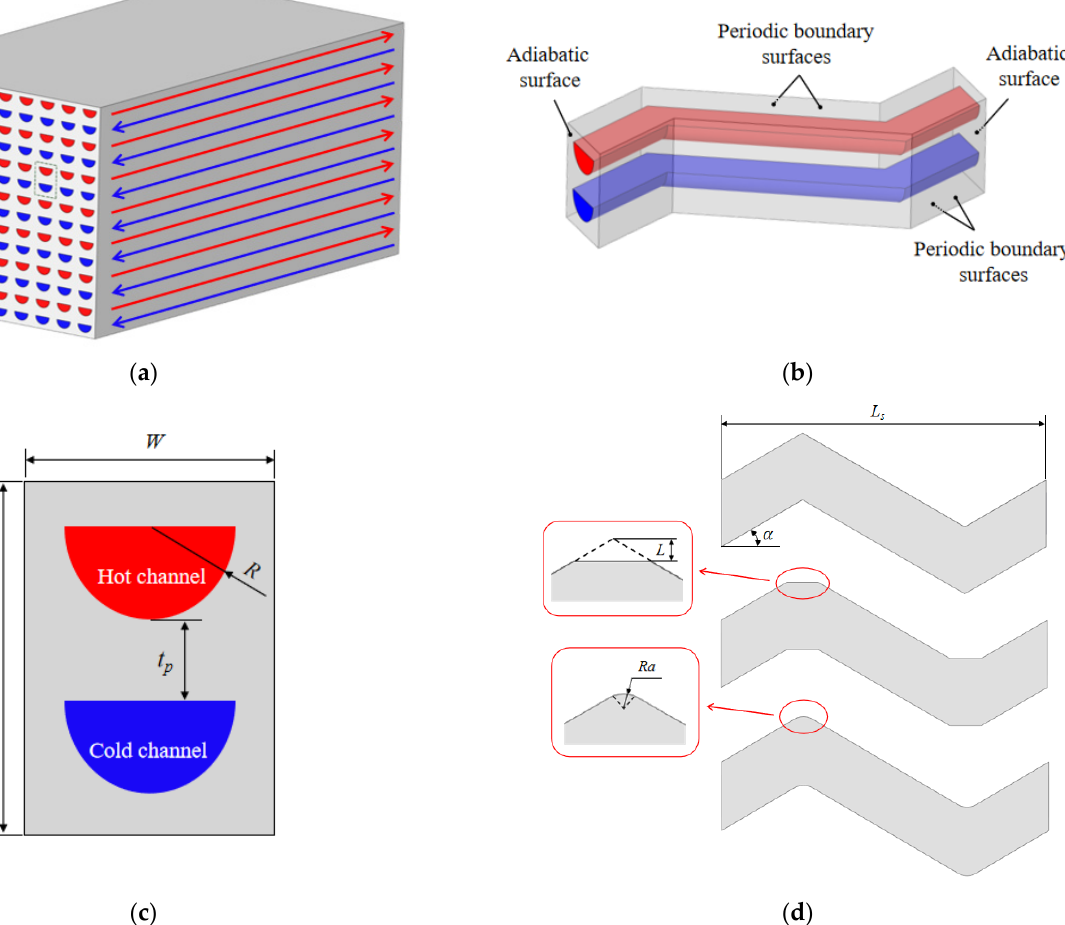
Figure 1. Schematic diagram of the structure of PCHE: ( a ) heat exchanger core; ( b ) Z-shaped channel single-pitch heat exchange unit structure; ( c ) the cross section of the heat exchange unit; ( d ) the single pitch of the conventional Z-shaped channel and two types of Z-shaped channels with straight sections or arc segments inserted at the zigzag corners.